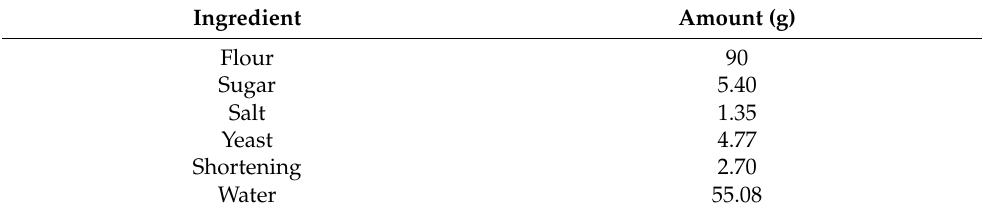
Table 2. Ingredients incorporated into intermediate wheatgrass